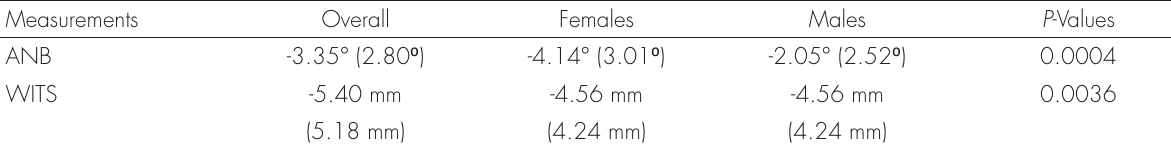
Table II. Pretreatment ANB and Wits values for the assessed Class III cohort.